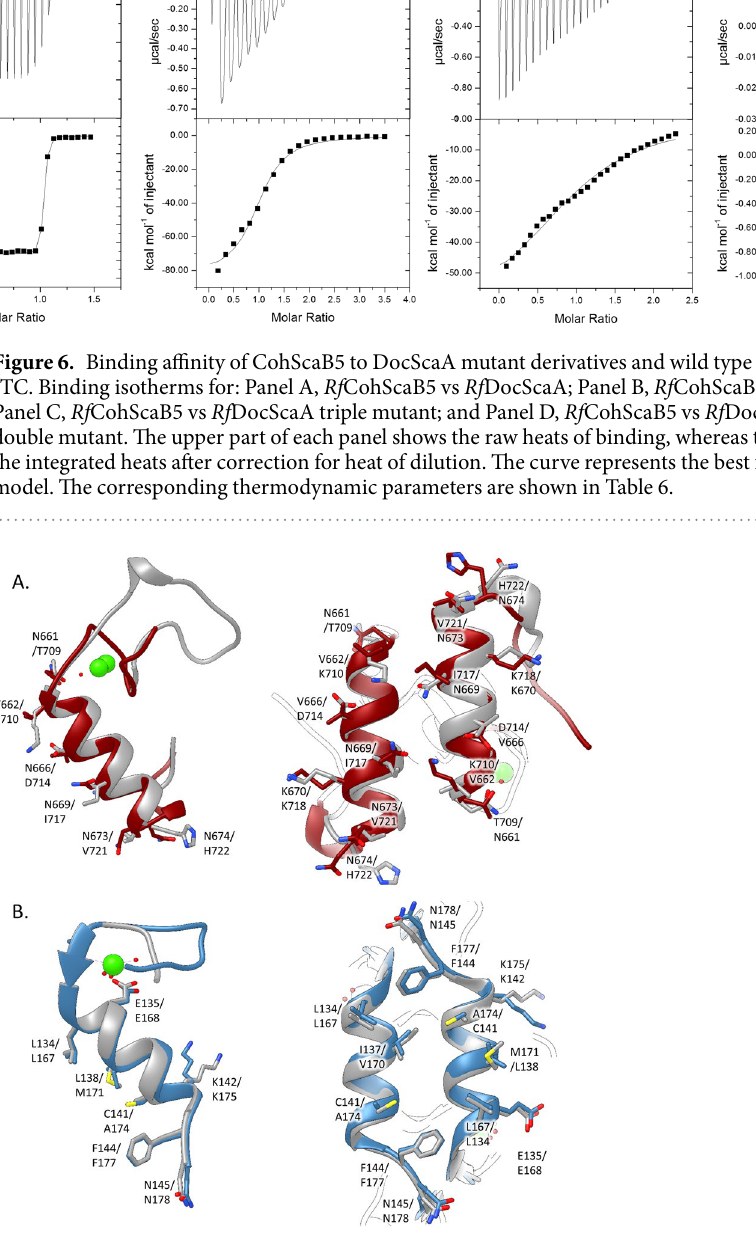
Figure 7. Non-symmetric and symmetric nature of Docs as exemplified by the structures of single-binding mode Rf DocScaA and dual-binding mode Ac DocScaA. Panel A, R. flavefaciens group5 Doc (DocScaA). Panel B, A. cellulolyticus DocScaA ( Ac DocScaA). The left image of each panel shows an overlay of the N-terminal and C-terminal dockerin repeats. In both cases it is apparent that the 2 repeats are similar at the main-chain atoms but only the Ac DocScaA (Panel B) shows conservation in the side chains, allowing the dual-binding mode. The right image of each panel shows a comparison of the two putative binding surfaces by overlaying the dockerins with a version of themselves rotated by 180° (in grey), showing a lack of conservation in the key contacting residues in the R. flavefaciens dockerins (Panel A). Contrary to the Ac DocScaA (Panel B), lack of internal symmetry in Rf DocScaA and the involvement of both α 1 and α 3 helices in cohesin recognition suggest that they display a single cohesin-binding